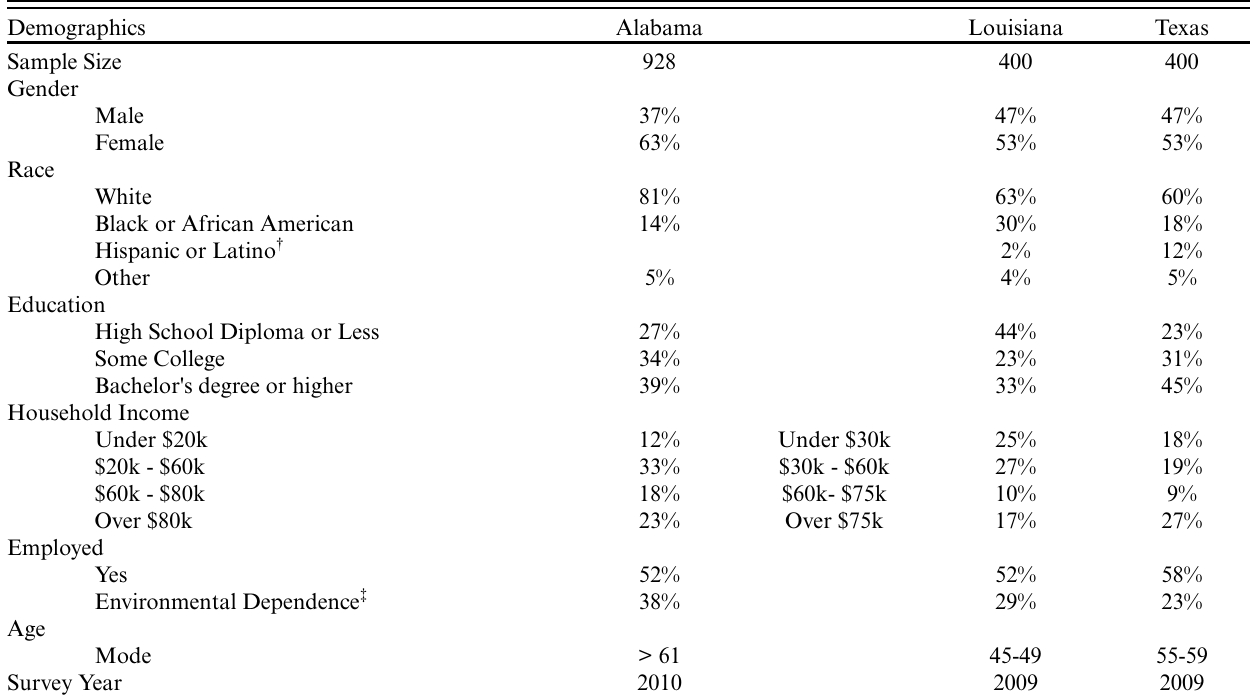
Table 1 . Sample descriptions and demographics for the three random-digit dial telephone